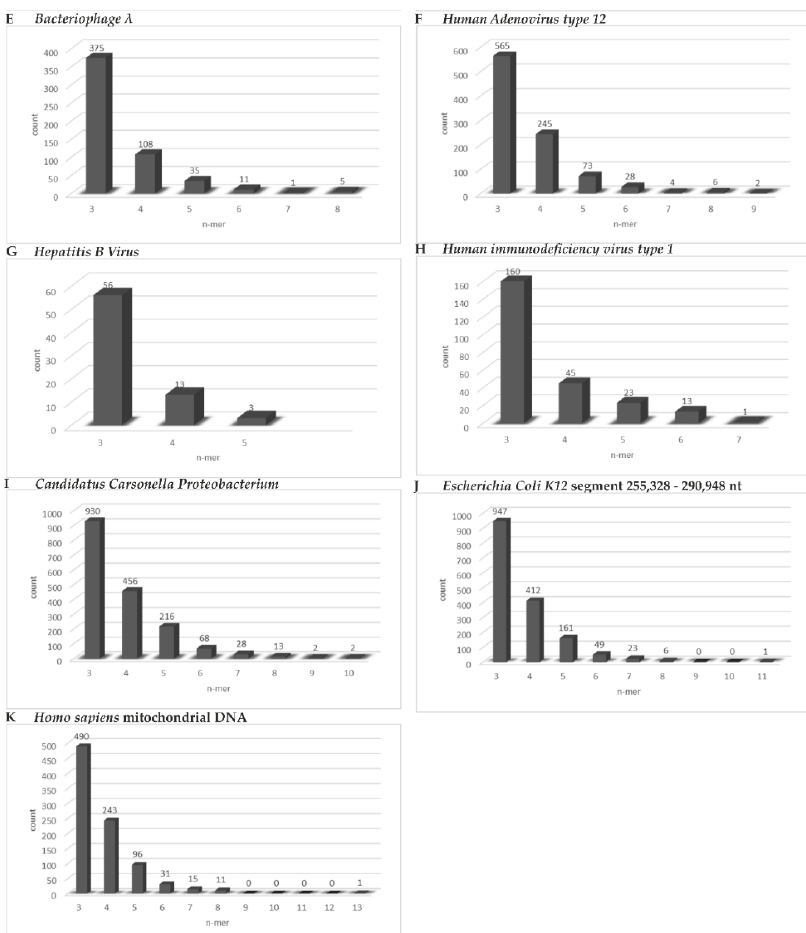
Figure 6. Table S2. Bar graphs. As described under Methods, the individual nucleotide sequences as indicated in the Table/Figures were aligned to the DNA-converted RNA sequence of SARS-CoV-2 . We analyzed these complex patterns of sequence identities by counting the total number of 3 to up to maximally 13-mers in each of the sequence alignments chosen for representative organisms. As apparent from the nucleotide sequence alignments [see Supplementary Material Figures S1–S4], sequence identities were highlighted in yellow. Individual identities of n-mers were quantitated and expressed as percent of total 3- to n-mers, as indicated. ( A – K ) summarize the results in the form of bar graphs, in Table S1 the actual numbers of 3- to 13-mers have been compiled. The bar graphs did not, however, reflect the complexity of actual patterns of sequence identities in individual classes that wee, however, apparent in the sequence alignments in Figures 1–4. The nucleotide sequences of the following organisms were aligned with the genome sequence of SARS-CoV-2 : ( A ) Circular double- stranded DNA with 17,663 nucleotides of the Archaea phage Sulfolobus turreted icosahedral virus . ( B ) RNA with 10,290 nucleotides of the plant virus Alternaria brassicicola betaendornavirus . ( C ) DNA with 7140 nucleotides of the plant virus Fig badna virus 1 . ( D ) Double-stranded DNA with 133,894 base pairs of the hymenopteran insect virus Autographa californica Nuclear Polyhedrosis Virus. ( E ) Double- stranded DNA with 48,502 nucleotide pairs of Escherichia coli bacteriophage lambda . ( F ) Double-stranded DNA with 34,125 nucleotide pairs of human adenovirus type 12 . ( G ) Partly double-stranded DNA with 3182 nucleotide pairs of human Hepatitis B Virus (HBV) . ( H ) Single-stranded RNA with 9719 bp of Human Immunodeficiency Virus-1 (HIV-1) . ( I ) Circular double-stranded DNA of the proteobacterium Candidatus Carsonella with 174,004 nucleotide pairs. ( J ) Sequence sub-segment comprising nucleotides 255,328 to 290,948 (arbitrary selection) from the 4,608,319 bp double-stranded circular genome of Escherichia coli K12 . ( K ) Circular double-stranded DNA of Homo sapiens mitochondrial DNA with 16,269 base